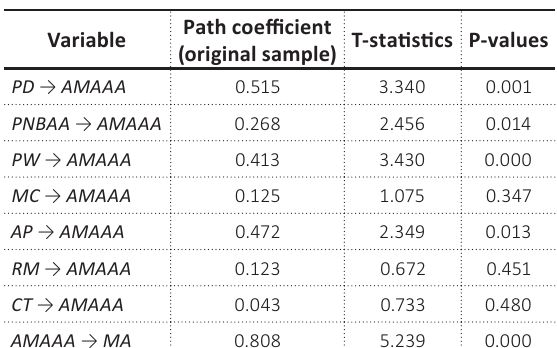
Table 4. PLS path algorithm testing and